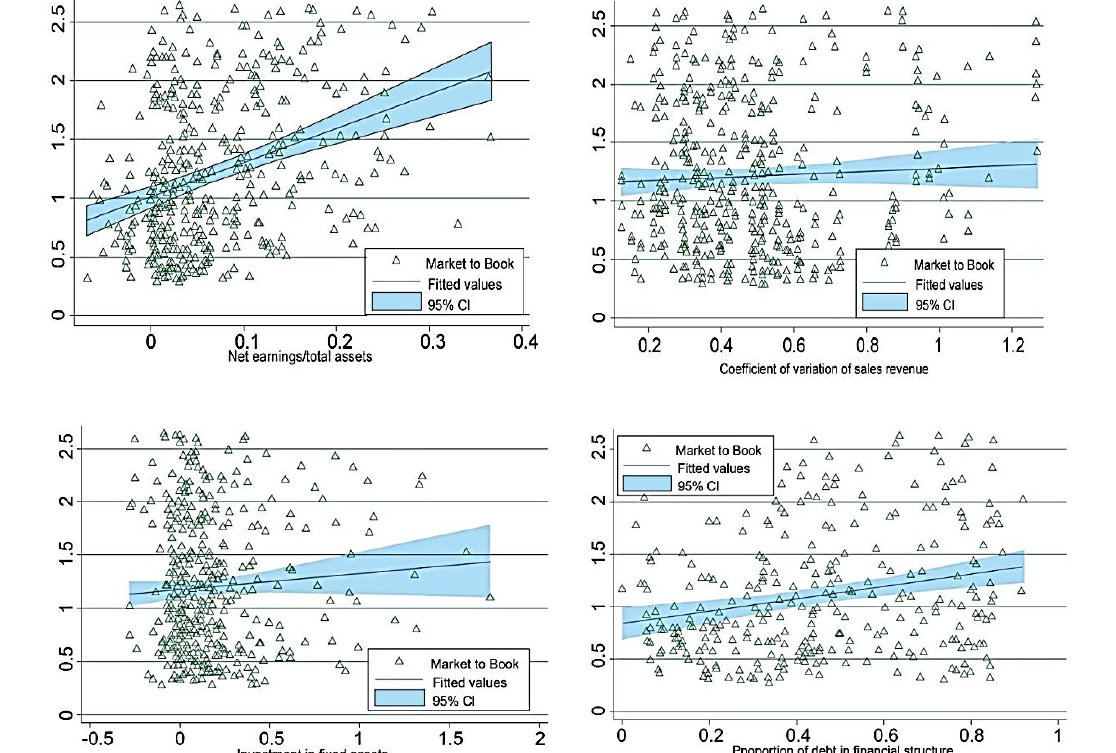
Figure 4. Financial company value